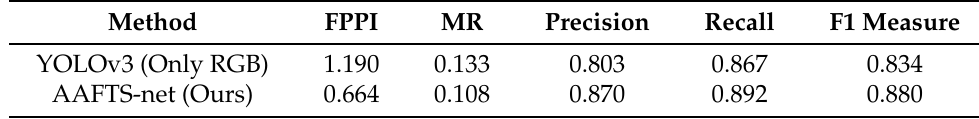
Table 3. Comparison of the results of AAFTS-net and YOLOv3 on the EPFL occlusion test set.